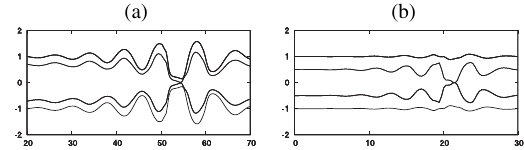
Fig. 9 Encapsulation of the core phase for the parameters in the experiment of Hertz and Hermanrud (3) , where almost the same liquid in the core and annular phases is used in (a), while di ff erent liquids are used in (b); (a) Wb = 48, σ = 0, ρ = 1, ¯ u 1 = ¯ u 2 = 1 and ¯ b = 0 . 3 at t = 62 . 50, (b) Wb = 48, σ = 2 . 6, ρ = 1, ¯ u 1 = ¯ u 2 = 1, ¯ b = 0 . 5 at t = 26 .